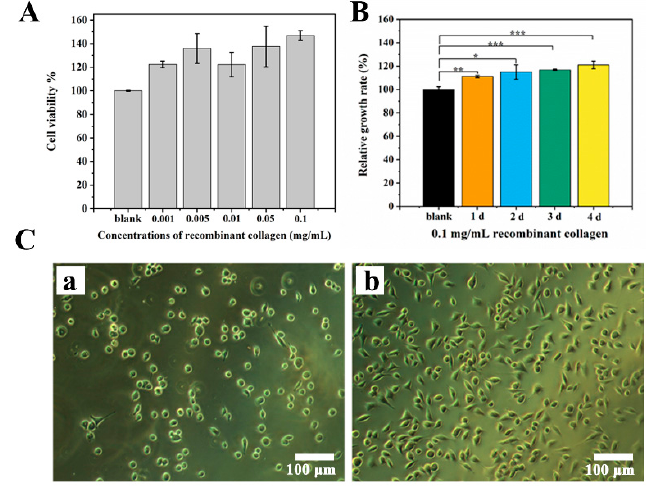
Figure 2. In vitro biocompatibility and bioactivity of THRC dressing. ( A ) Cytotoxicity to L929 fibroblasts of THRC dressing at various concentrations of THRC (0.001, 0.005, 0.01, 0.05, and 0.1 mg/mL). ( B ) The relative growth rates of L929 fibroblasts cultured in 0.1 mg/mL THRC dressing solution on days 1, 2, 3, and 4. ( C ) Cell adhesion images on ( a ) 1% heat‑denatured BSA and ( b ) 0.1 mg/mL THRC dressing surfaces. * p < 0.05, ** p < 0.01, *** p < 0.001, ns > 0.05, n = 6.